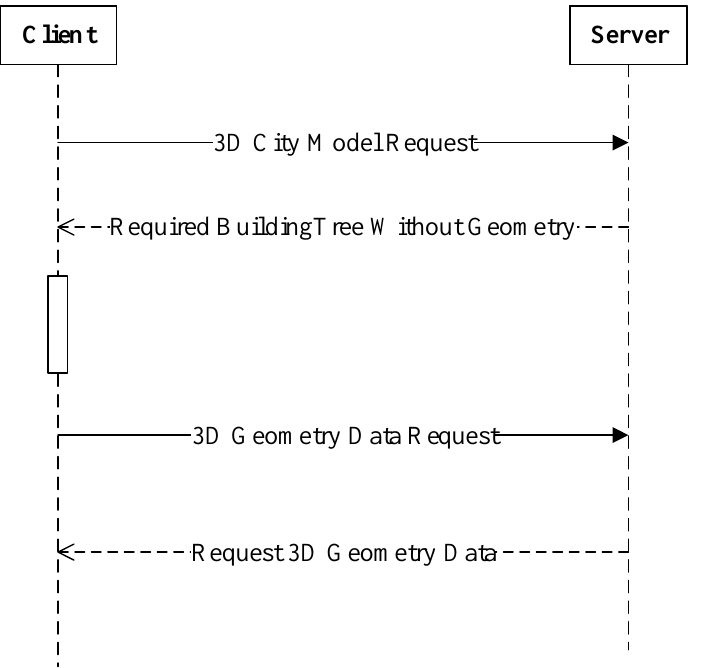
Figure 8. Interaction between client and server of BuildingTree visualization.